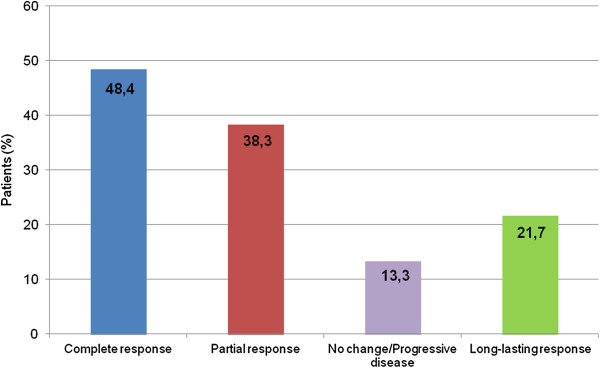
Treatment response.